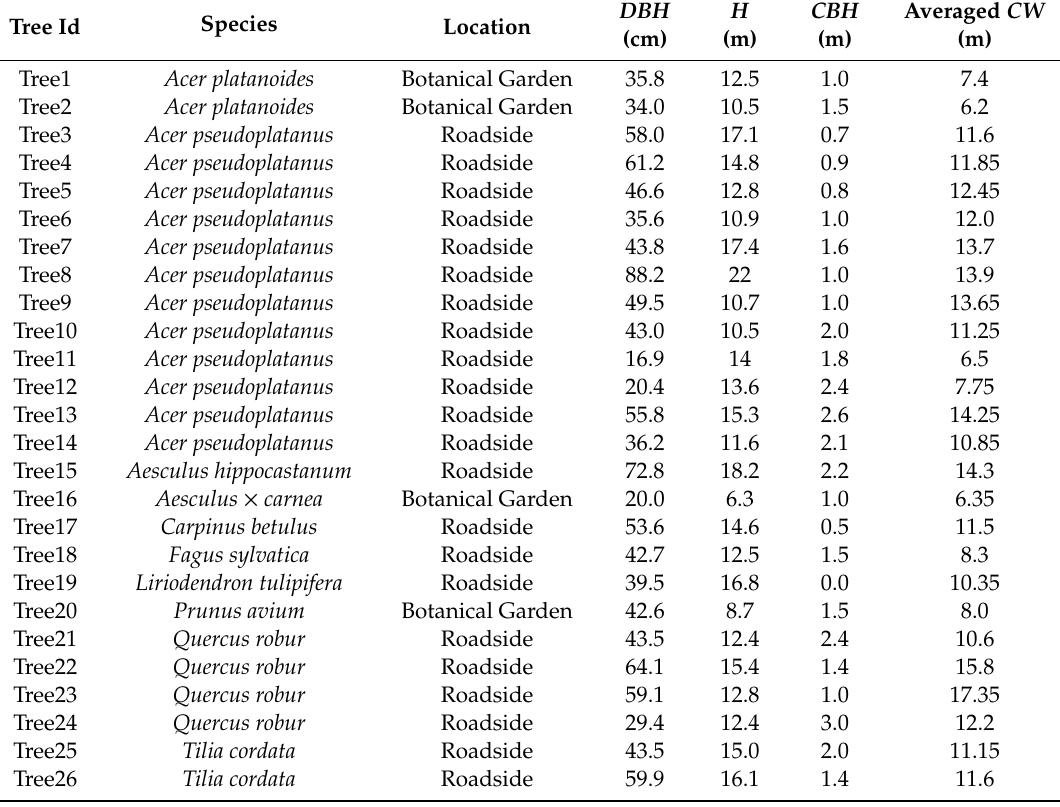
Table 2. The sample trees and their major crown-relevant characteristics.